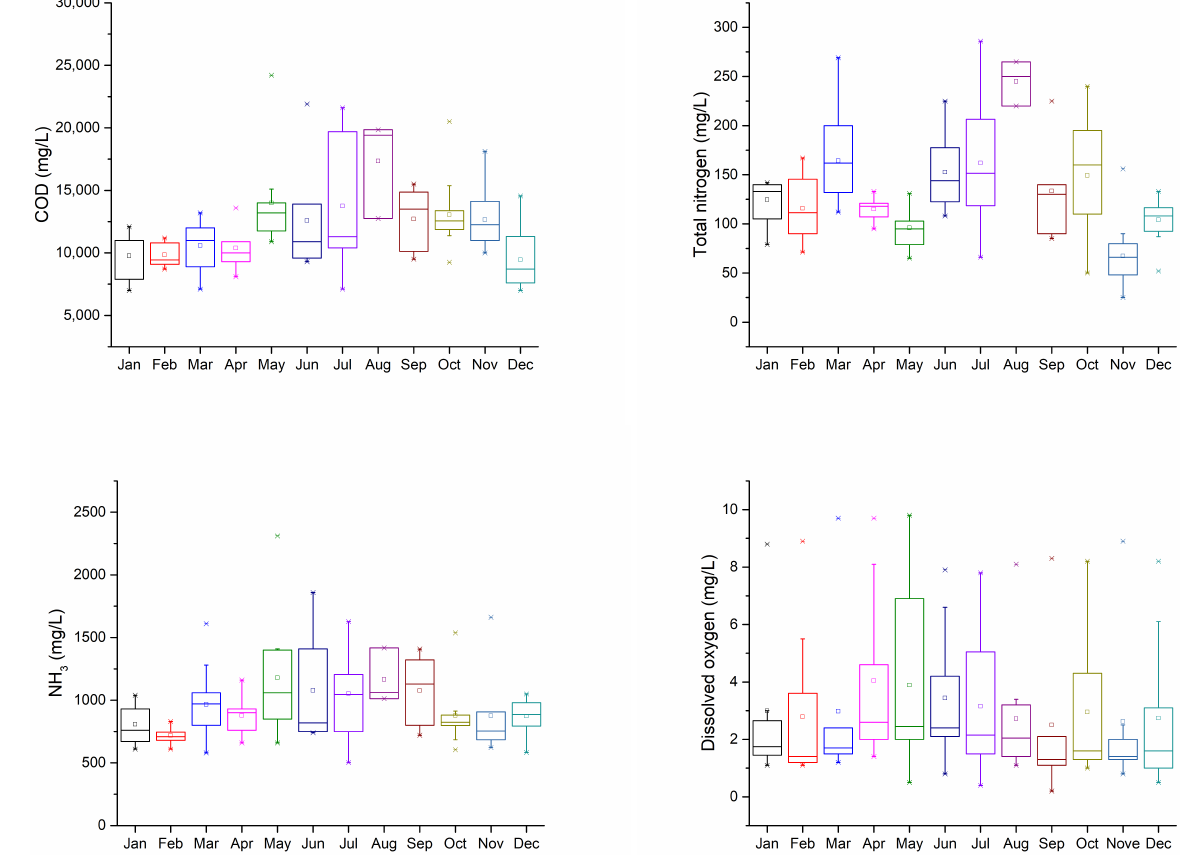
Figure 3. Monthly average concentrations for COD, NH 3 , TN and DO in